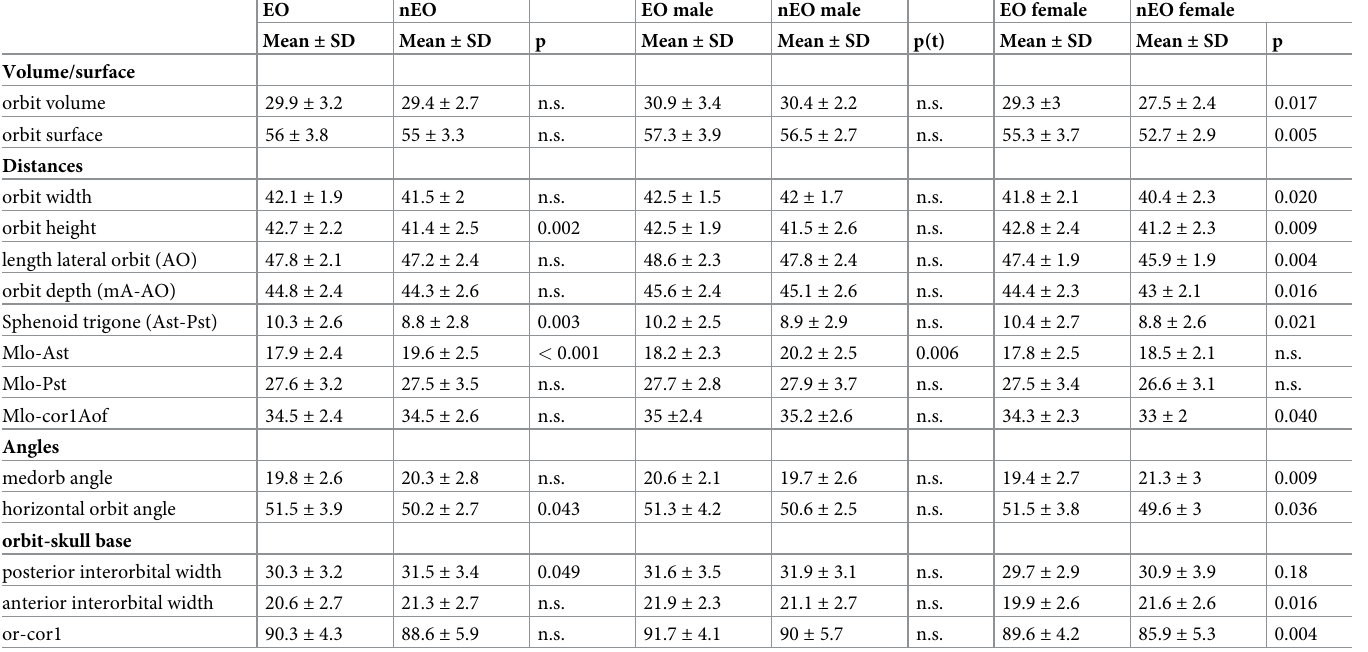
Table 3. Comparison of EO versus nonEO CT